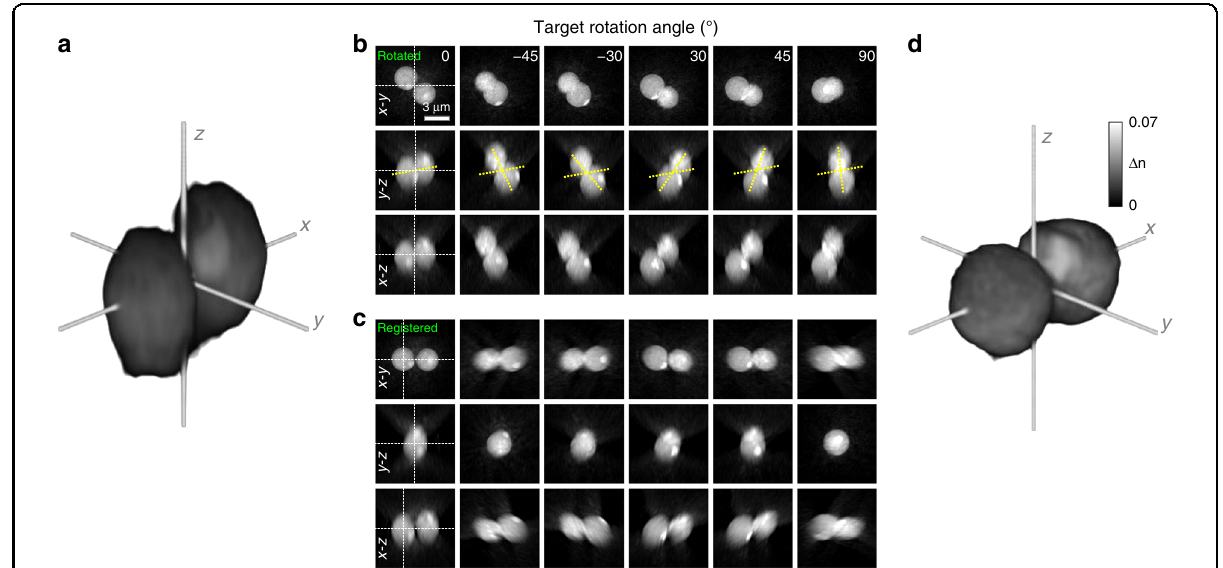
Fig. 2 Validation of the isotropic reconstruction process using a standard sample. a Raw RI tomogram of a PMA dimer reconstructed by conventional ODT. b , c Sliced tomogram images of the sample rotated by TOMOTRAP. b Raw data. c Registered results. The lateral pitch axis of the raw data was rotated by 45° with respect to the x -axis, and registered to the y -axis. The yellow and white dashed lines indicate rotational angles and the cross-sections, respectively. d Isotropic RI tomogram obtained from the registered